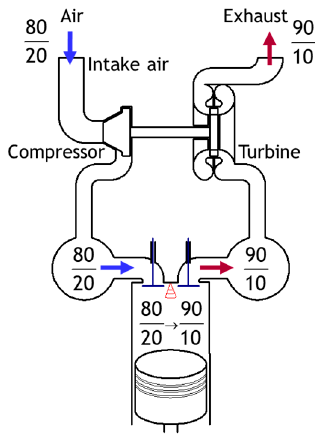
Figure 1. The mass balance for a non-EGR supercharged diesel engine.